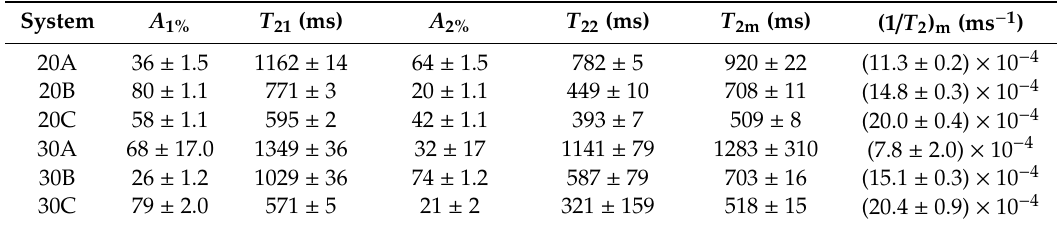
Figure 2. Experimental relaxation behavior of the modulus ( I s ) of the xy component of the magnetization vector referring to ( a ) hydrogels 20A (% polymer mass percentage = 20.5% and 22 min irradiation), 20B (% polymer mass percentage = 20.5% and 33 min irradiation), and 20C (% polymer mass percentage = 20.5% and 44 min irradiation); and ( b ) hydrogels 30A (% polymer mass percentage = 30.5% and 22 min irradiation), 30B (% polymer mass percentage = 30.5% and 33 min irradiation), and 30C (% polymer mass percentage = 30.5% and 44 min irradiation). Equation (5) best fitting is not visible as it practically coincides with the experimental data. t is time. Table 3. Equation (5) fitting parameters ( A i% , T 2i ), average relaxation time, T 2m , and average inverse relaxation time (1 / T 2 ) m (Equation (6)).